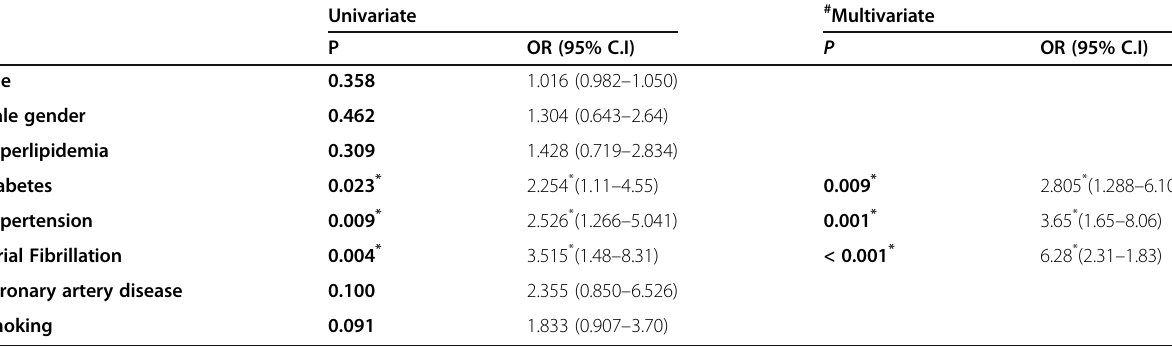
Table 3 Univariate and multivariate analysis between study variable (demographic and risk factors) and poor functional outcome Univariate